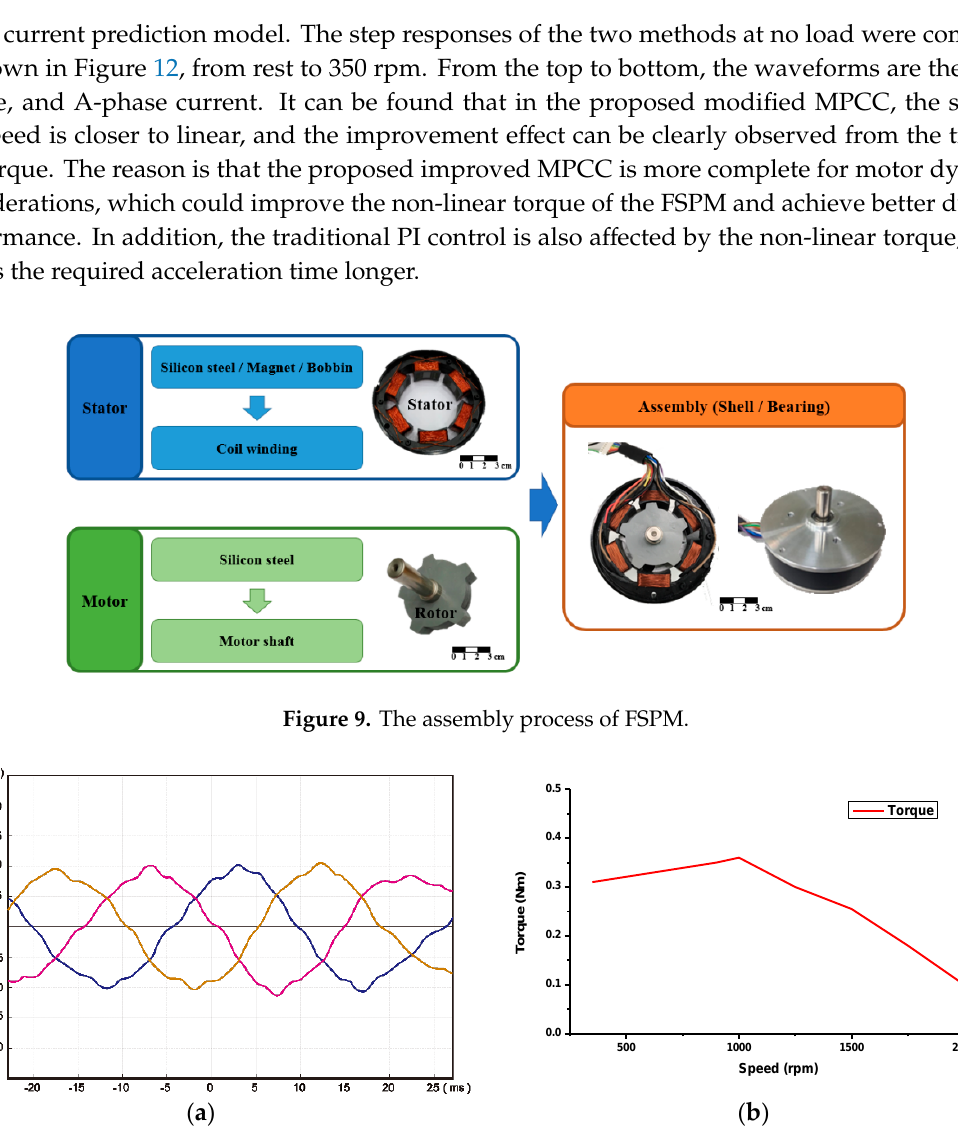
Figure 10. The measurement of ( a ) back ‐ EMF, and ( b ) the N ‐ T curve of FSPM under an input current of 9 A and a rated speed of 1000 rpm.